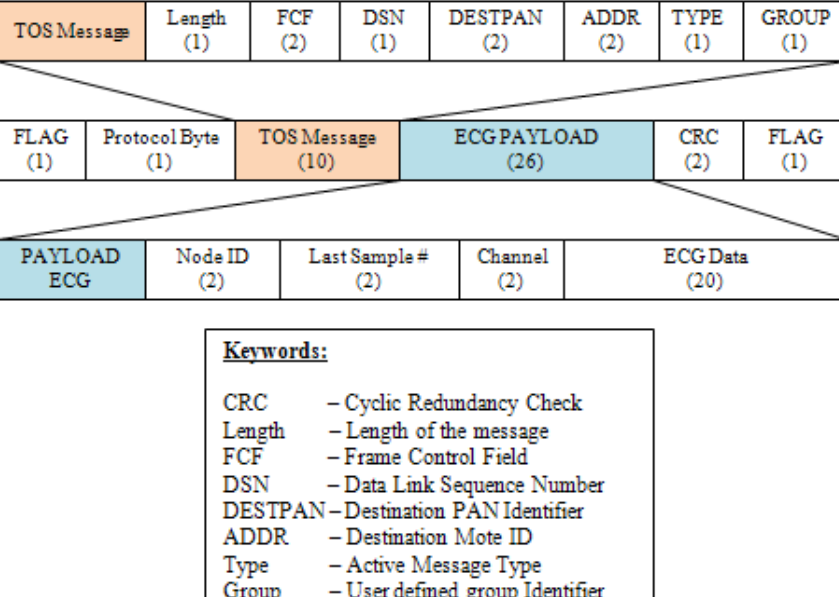
Figure 4. Packet format of sensor